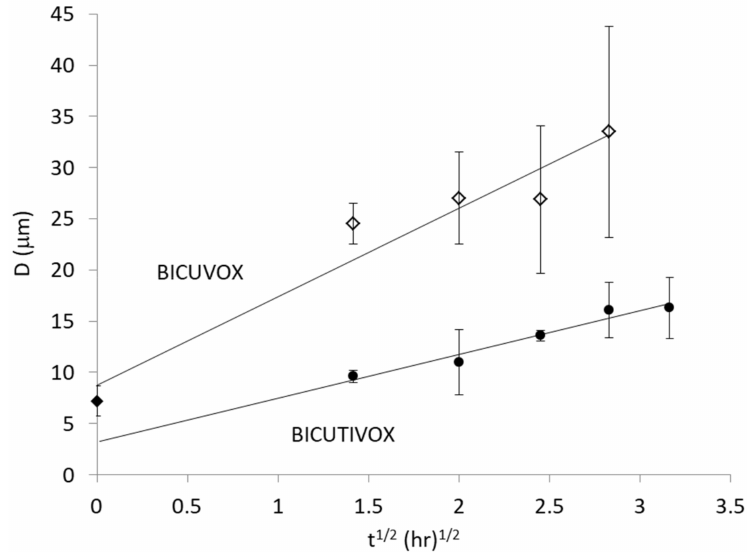
Figure 9. Platelet diameter versus the square root of time plots for BICUVOX and BICUTIVOX at an MSS process temperature of 650 ◦ C. Exception: The solid point at t = 0 is the experimental grain size of BICUVOX measured from solid salt synthesis at 610 ◦ C, and it is taken as an approximation of the starting grain size (error bars show ± one D stdev ).